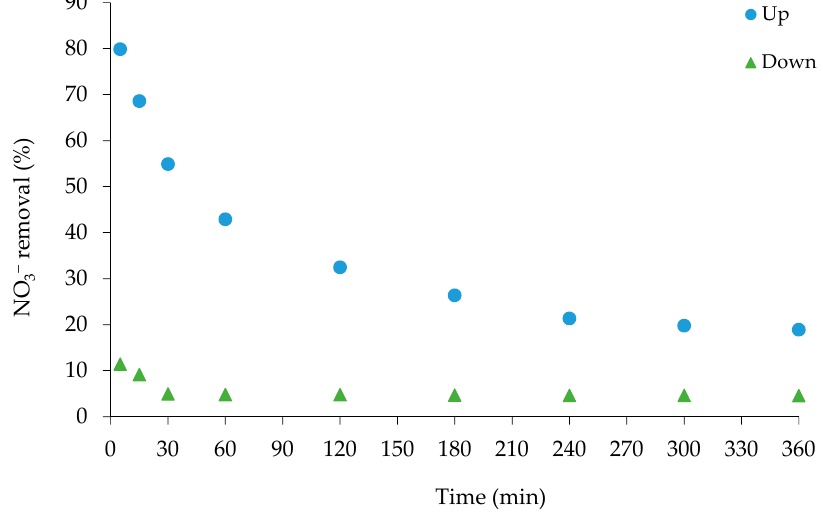
Figure 10. Upward and downward flow column adsorption experiment for 6 h.